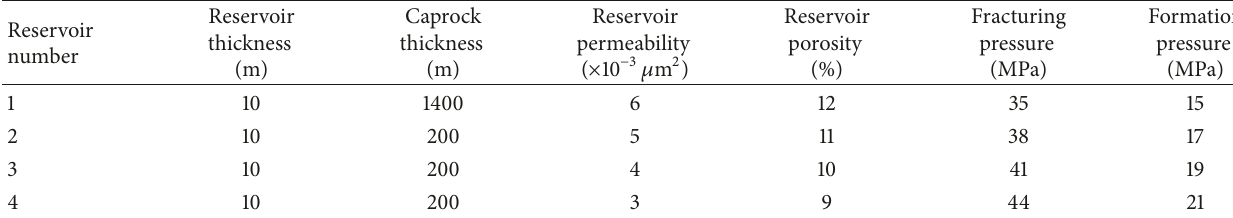
Table 1: The parameters of reservoir-caprock combination units.